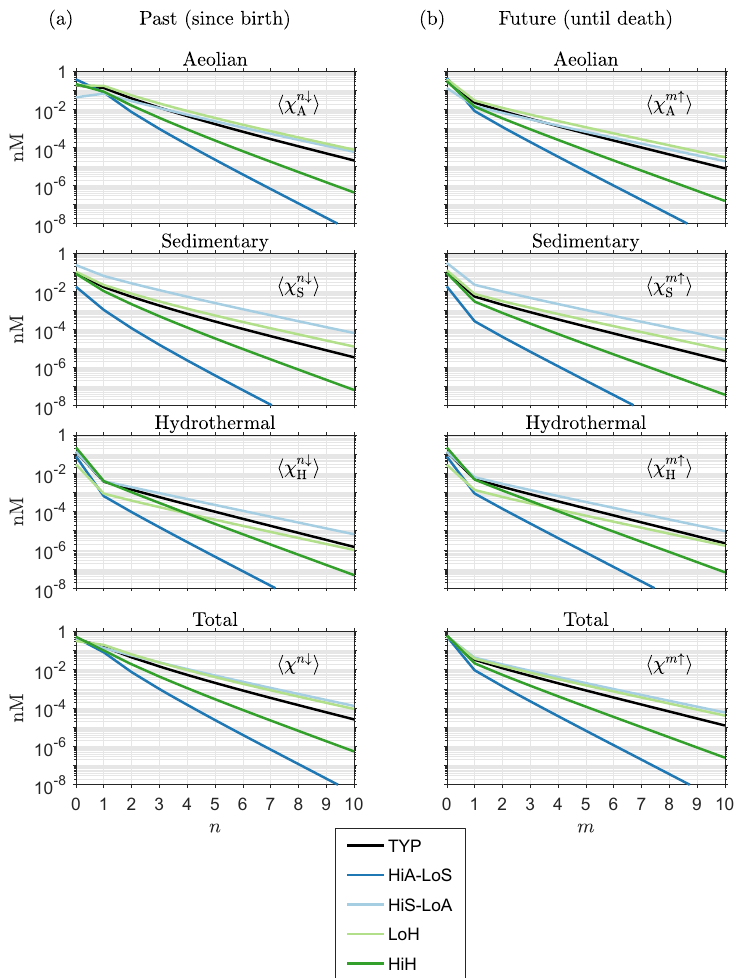
↓ (cid:105) , as a function of n for five representative states of the k ↑ (cid:105) , as a function of m . k